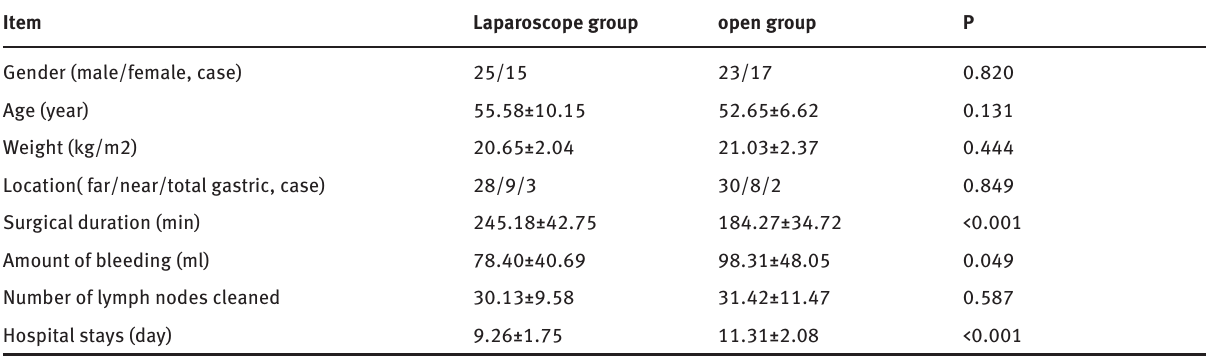
Table 1: General data comparison between two group